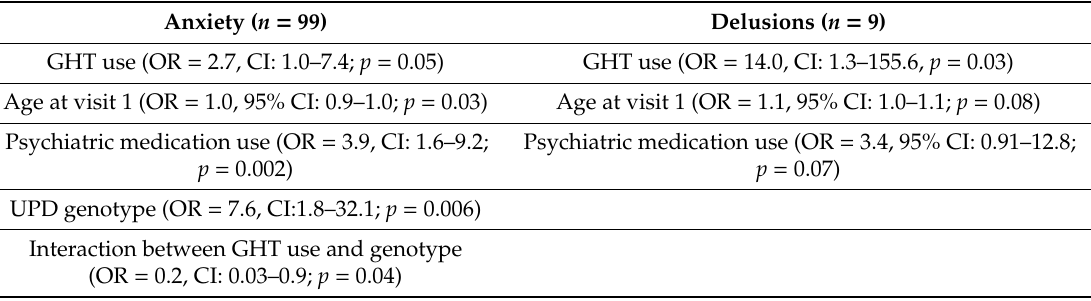
Table 4. Covariables included in the multivariable model for anxiety and delusions.